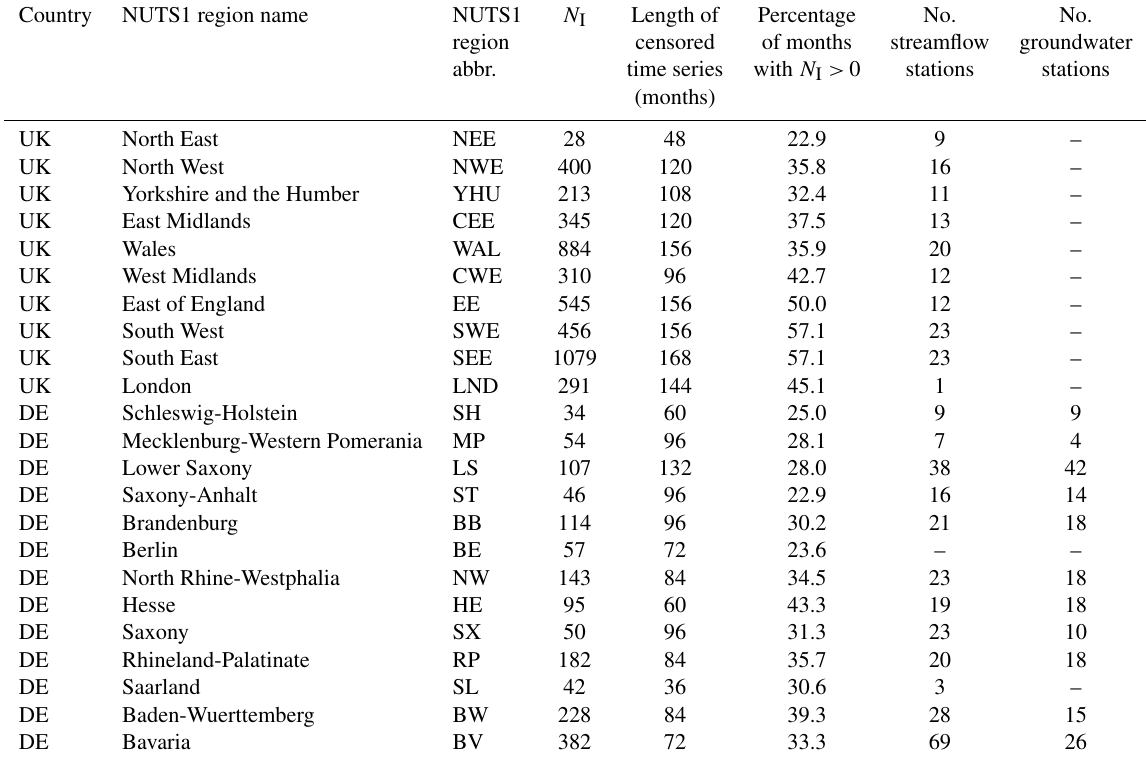
Table 1. Information on NUTS1 regions in the UK and Germany (DE) considered for analysis.